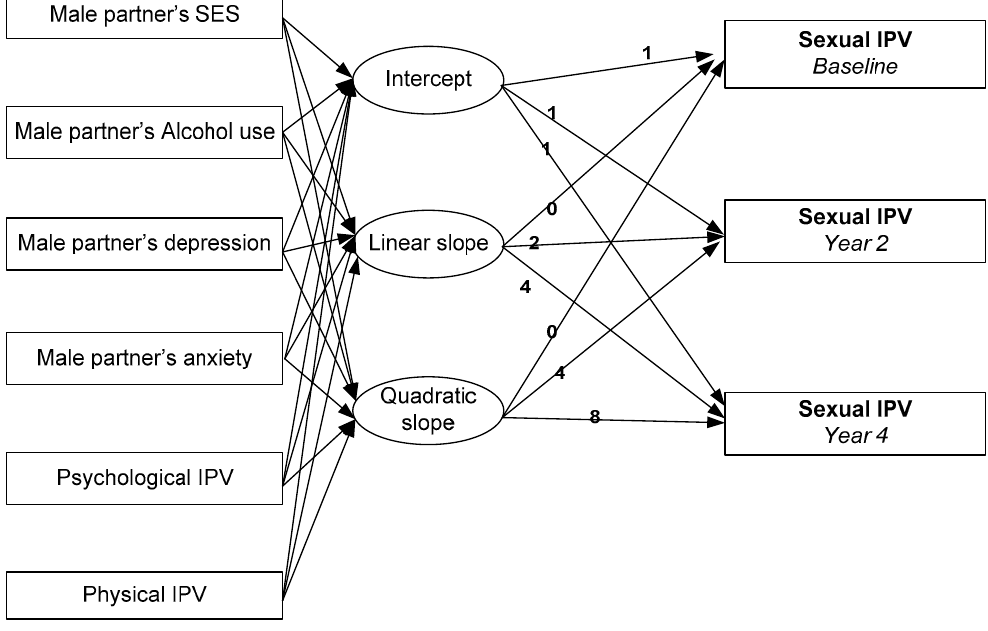
Figure 1. Diagram representing latent growth curve model in our study. IPV: intimate partner violence.